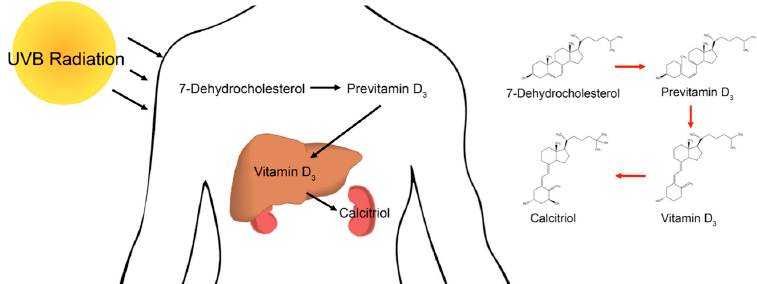
Figure 1. Illustration showing the conversion of 7-dehydrocholesterol into the active metabolite calcitriol in human liver and kidneys.